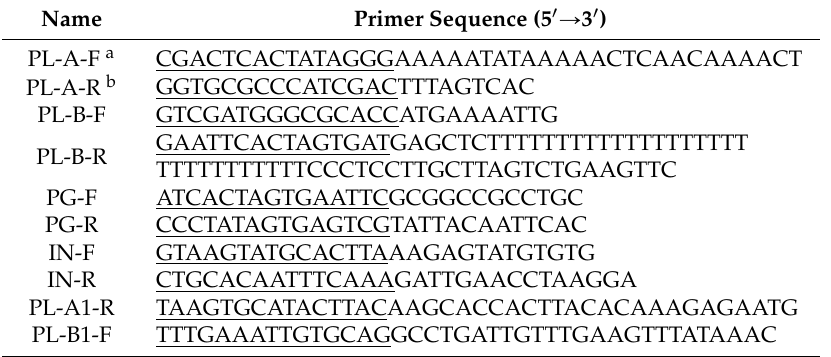
Table 1. Primers used in construction of infectious full-length cDNA clone of